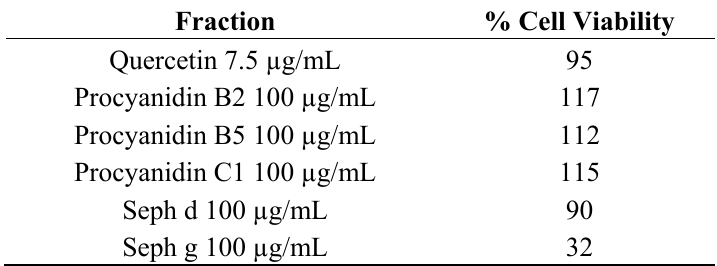
Table 3. MTS assay was used to determine cell viability in LPS-stimulated RAW 264.7 treated with procyanidins and proanthocyanidin-rich fractions of aronia. Quercetin was used as a positive